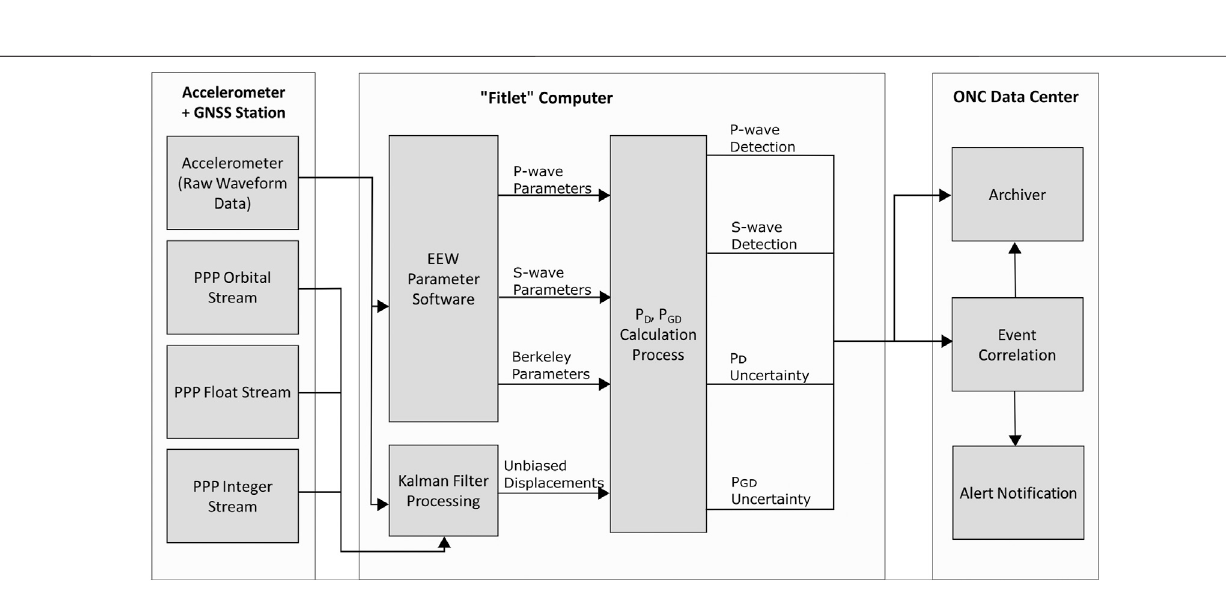
Frontiers in Earth Science |